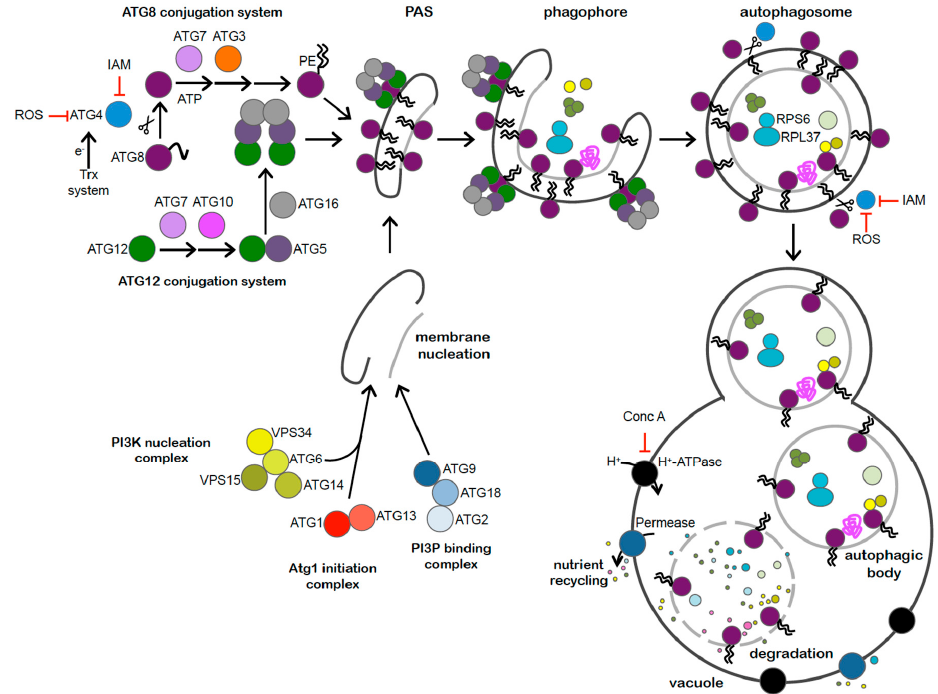
Figure 1. The autophagy machinery from Chlamydomonas. Most of the ATG proteins that compose the core autophagy machinery and participate in the formation of the autophagosome are conserved in Chlamydomonas. The ATG1 initiation complex, composed by ATG1 and ATG13, catalyzes the initial steps of autophagy. Then, the PI3K nucleation complex—constituted by ATG6, ATG14, VPS15 and VPS 34—participates in the membrane nucleation process and in the recruitment of PI3P binding complex formed by ATG2, ATG9, and ATG18, which is involved in the expansion of the phagophore. Next, the two conjugation systems, ATG8 ubiquitin-like system, composed by ATG8, ATG4, ATG7 and ATG3, and ATG12 ubiquitin-like system—composed by ATG12, ATG7, ATG10, ATG5, and ATG16—act coordinately to accomplish vesicle expansion, autophagosome formation, cargo recognition and autophagosome targeting to the vacuole. The ATG4 protease from Chlamydomonas is activated by the thioredoxin (Trx) system and reversibly inhibited by ROS or irreversibly inactivated by blocking agents such as iodoacetamide (IAM). Cytosolic components including ribosomal proteins such as RPS6 and RPL37 are engulfed by the autophagosome and targeted to the vacuole where they are finally degraded and recycled. Inhibition of vacuolar H+ ATPase with concanamycin A (Conc A) blocks autophagic flux. Accession numbers (from Phytozome https://phytozome.jgi.doe.gov/pz/portal.html) of Chlamydomonas ATG proteins are: ATG1 (Cre09.g391245.t1.1); ATG13 (Cre16.g659000.t1.1);